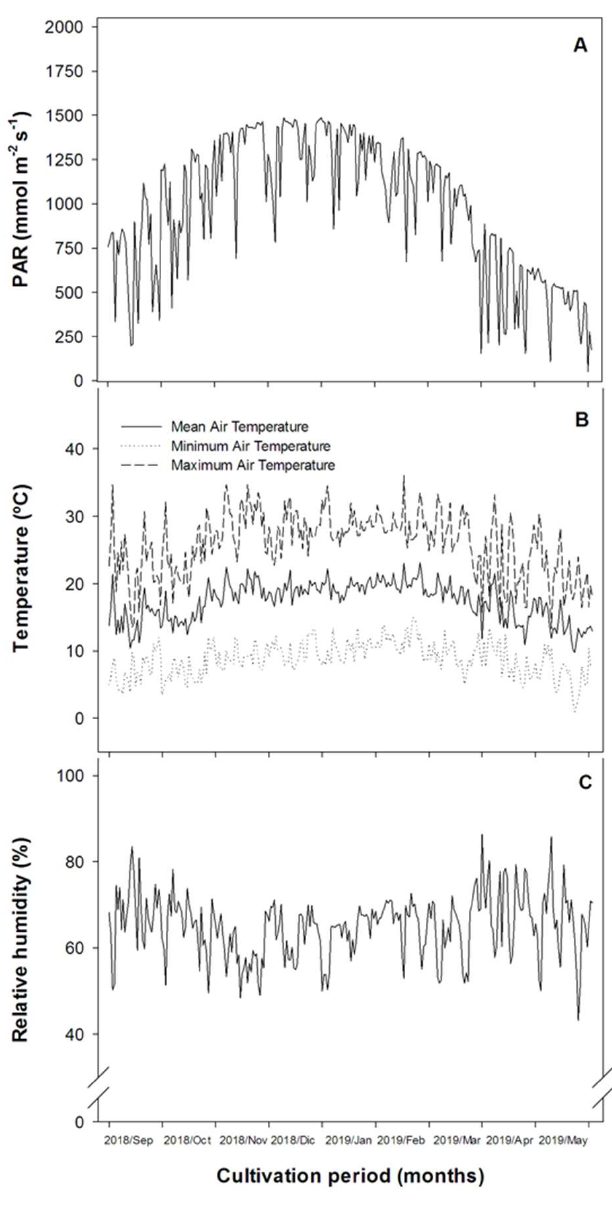
Figure 1. Photosynthetic active radiation-PAR ( µ mol m − 2 s − 1 ) ( A ); variation in minimum, mean and maximum air temperatures ( ◦ C) ( B ); relative humidity (5) ( C ) recorded in La Cruz-Chile outside the greenhouse during the 2018–2019 cultivation period. Each figure reports daily monthly averages. The database used can be accessed by request.